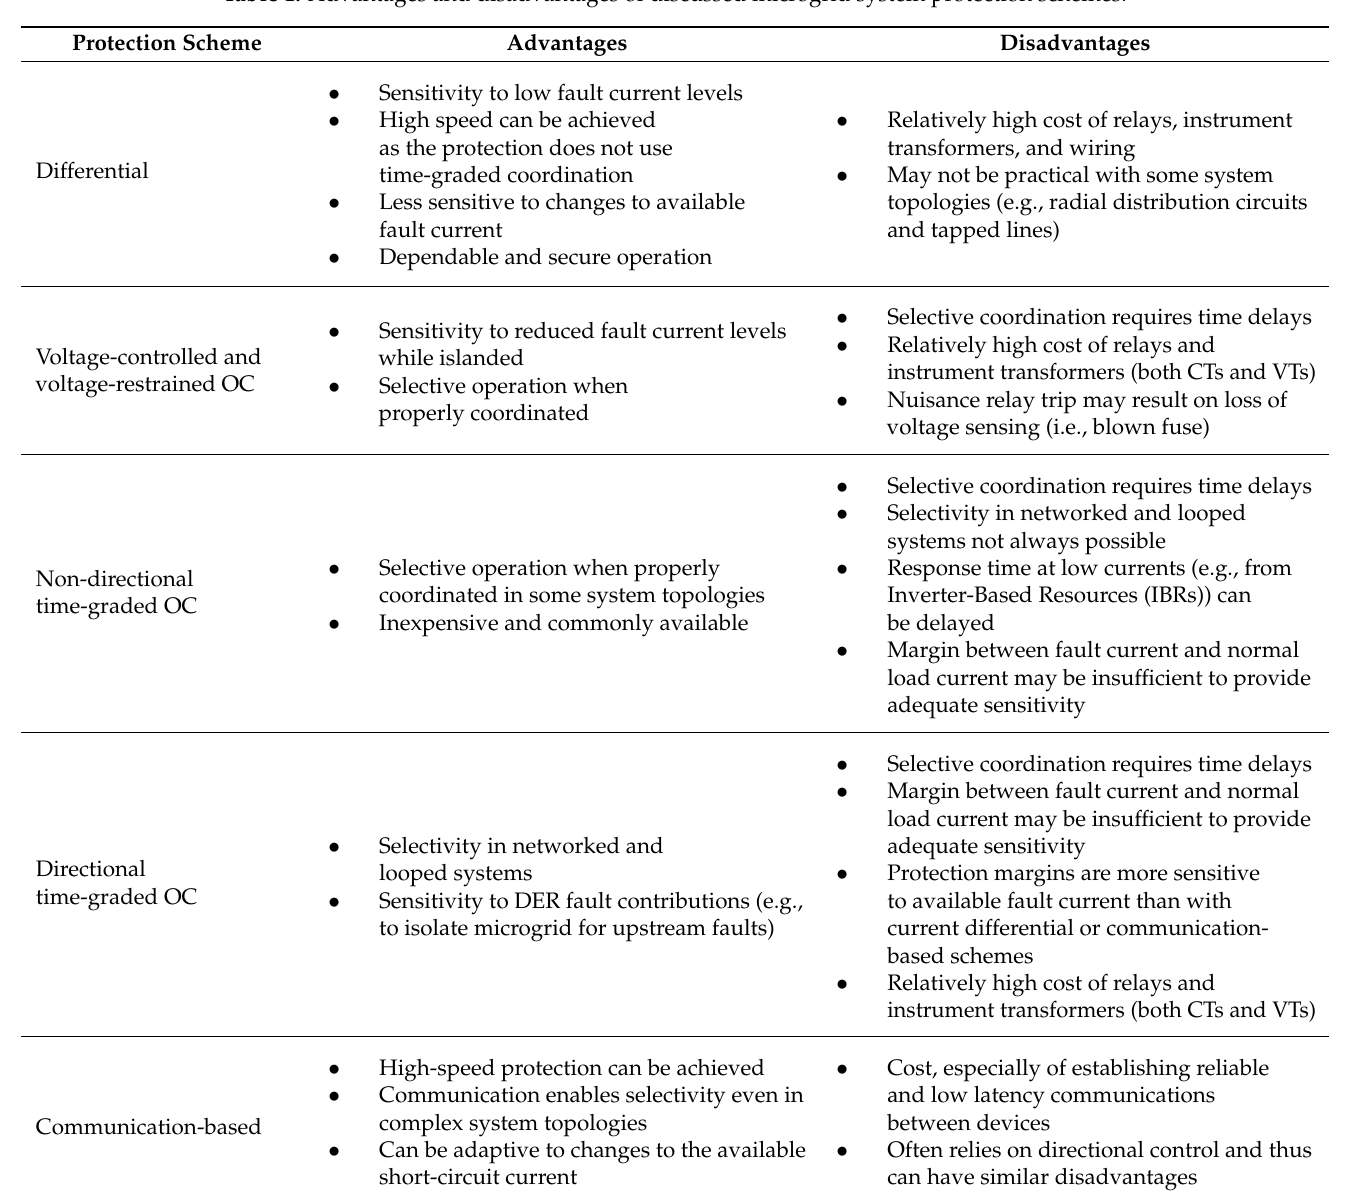
Table 1. Advantages and disadvantages of discussed microgrid system protection